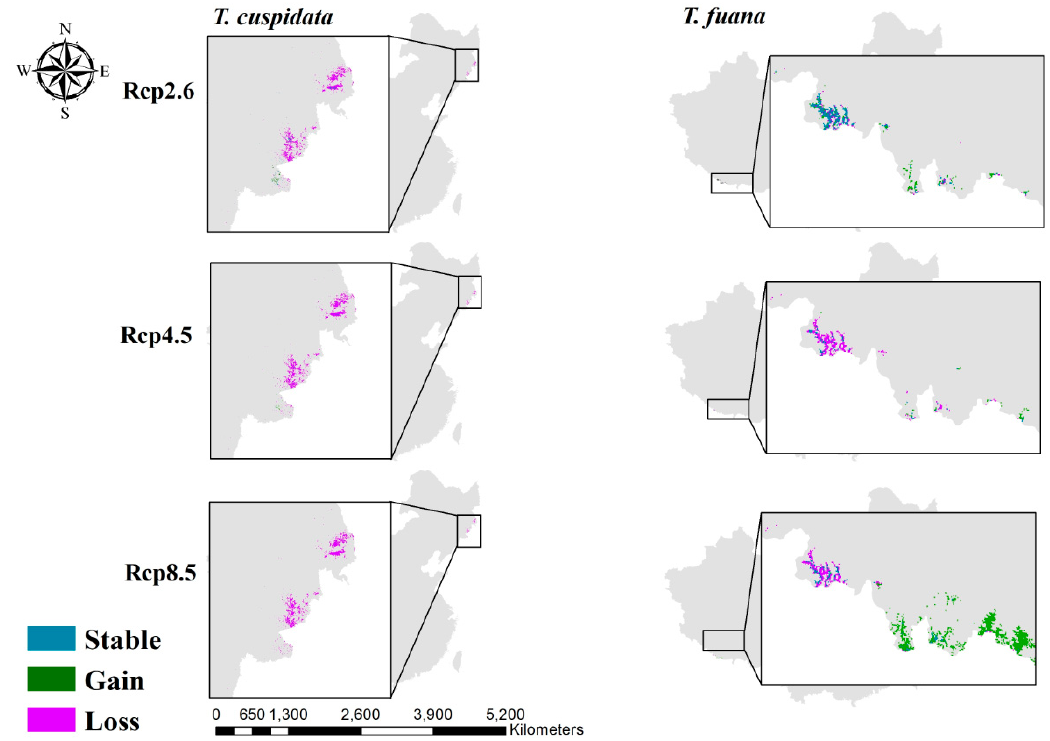
Figure 5. Spatial changes in the distribution ranges for T. cuspidata and T. fuana between current and future environmental conditions, simulated by SDMs with the constraints of topography.